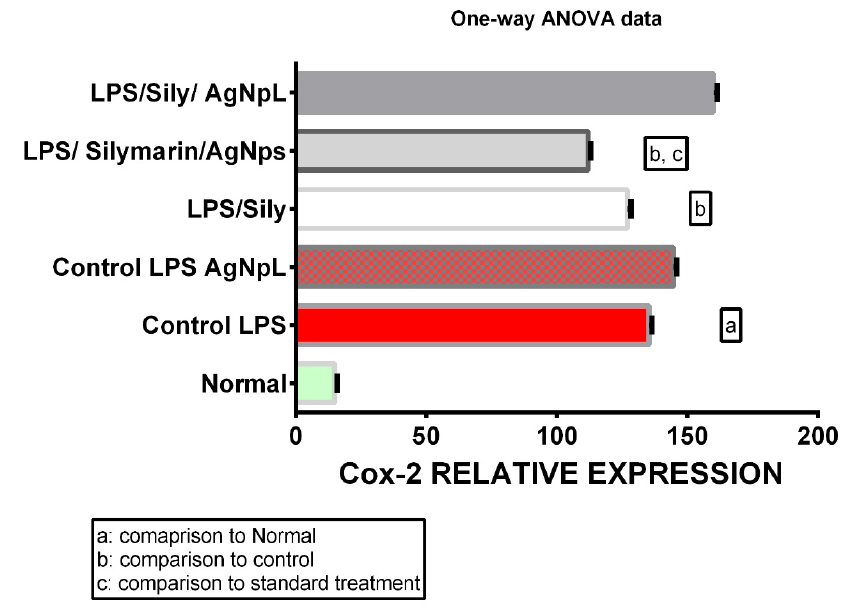
Figure 9. Expression levels of COX-2 among different groups.